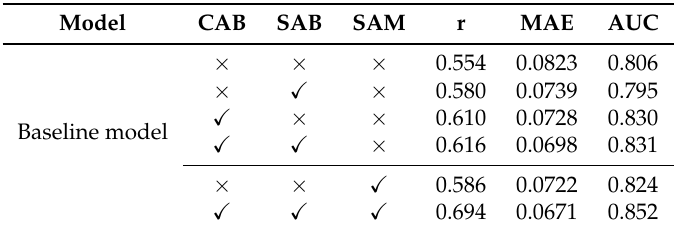
The results with and without channel attention block, spatial attention block and segmentation-auxiliary